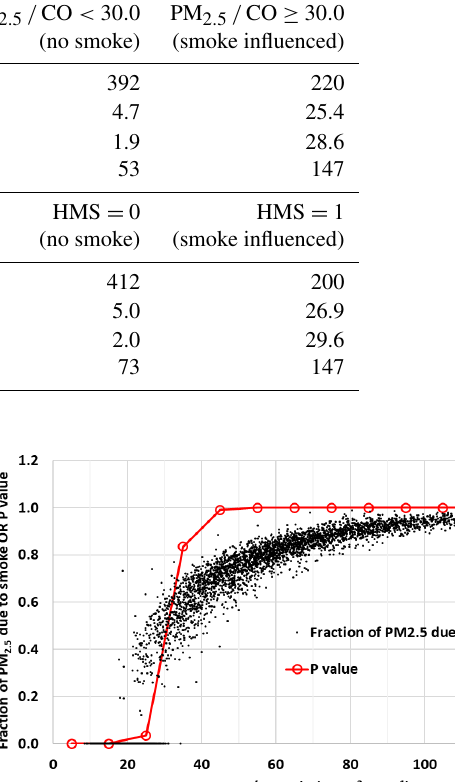
Table 3. Sparks daily PM 2 . 5 and CO data for May–September 2018–2021, segregated by the PM 2 . 5 / CO ratio and by overhead HMS smoke. PM 2 . 5 / CO < 30 . 0